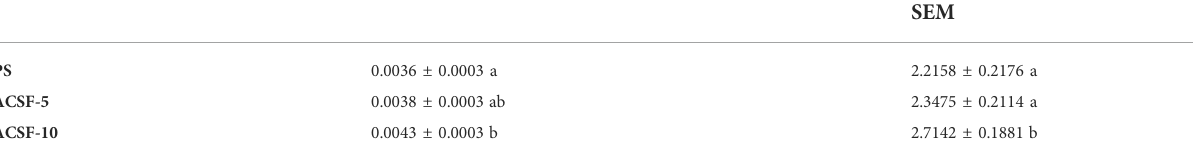
TABLE 3 Mean kinetics of GST in parent and acetamiprid larval-selected strains of Aedes aegypti.